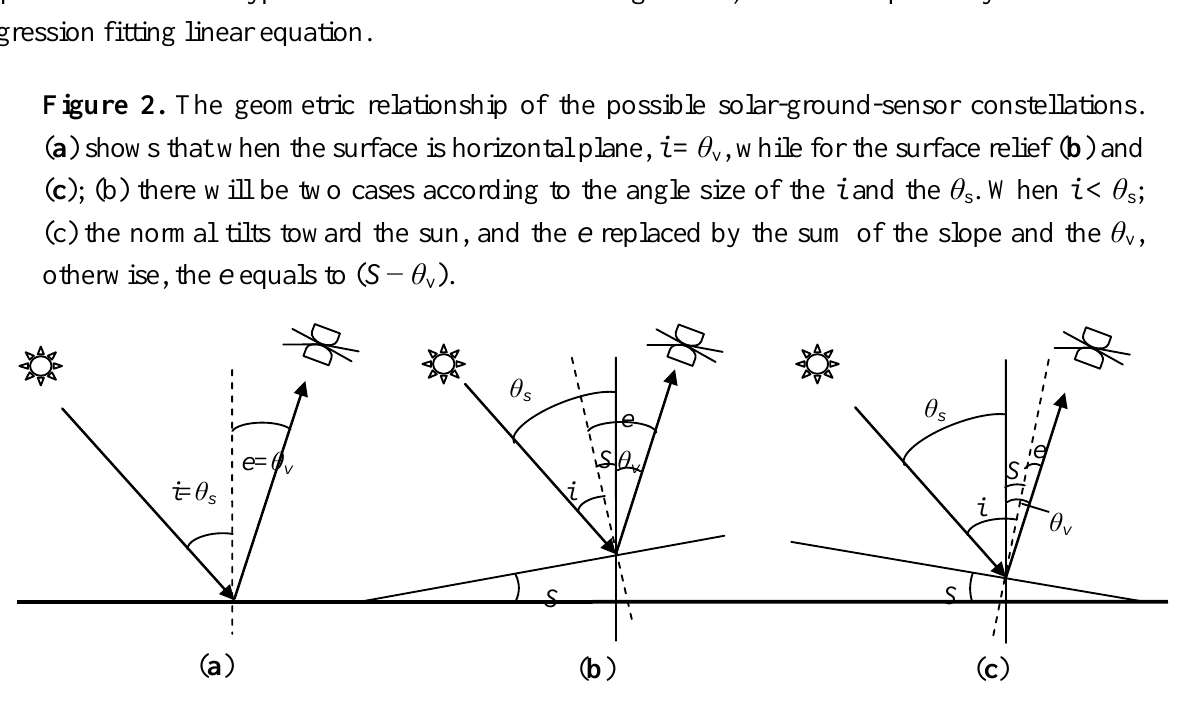
, while for the surface relief ( b ) and v